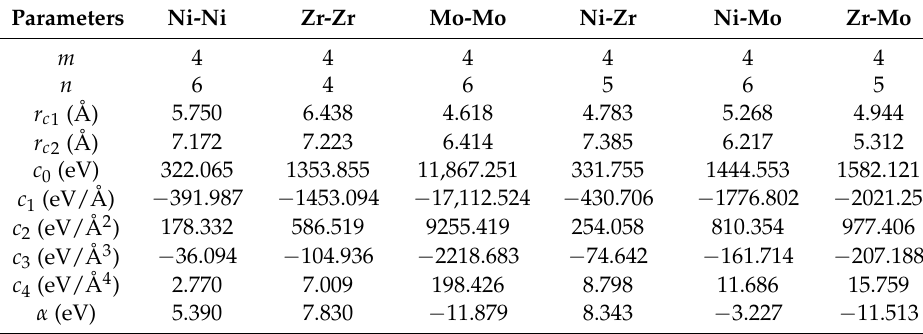
Table 2. The parameters of the constructed potential for the Ni-Zr-Mo system [56]. Parameters